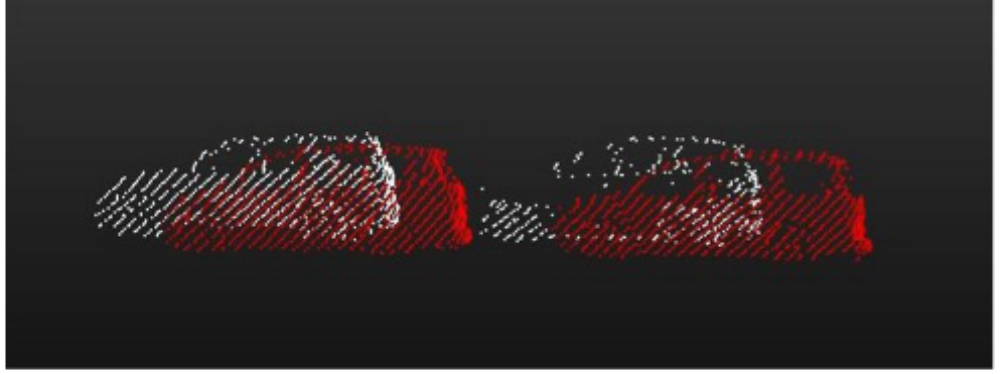
Figure 3. 3D points of moving vehicles in the urban scene. In red, the 3D points acquired from S − 01 , and in white, the 3D points acquired from S − 02